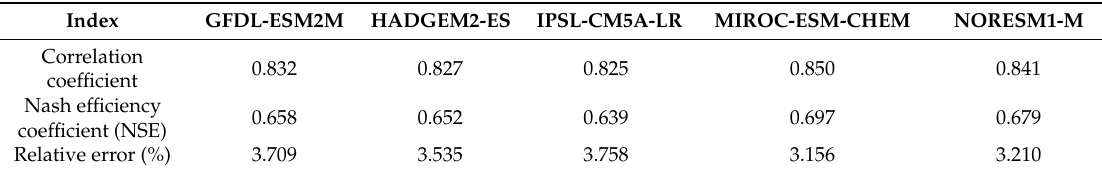
Figure 6. Comparison between the measured values and the five representative models original values (annual precipitation from 1961 to 2000). Table 4. Index comparison between the measured values and the five representative models original values (monthly precipitation from 1961 to 2000).